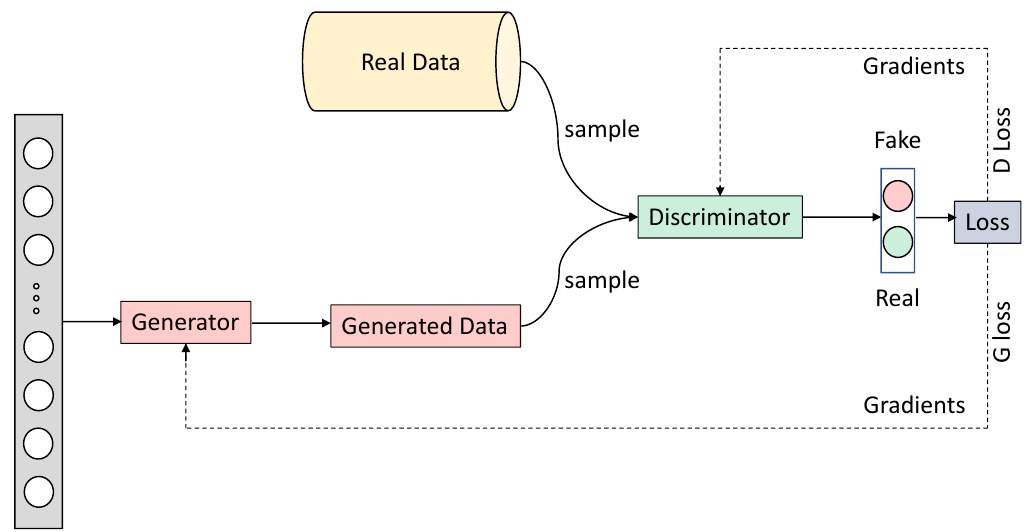
Figure 1. Generative Adversarial Network